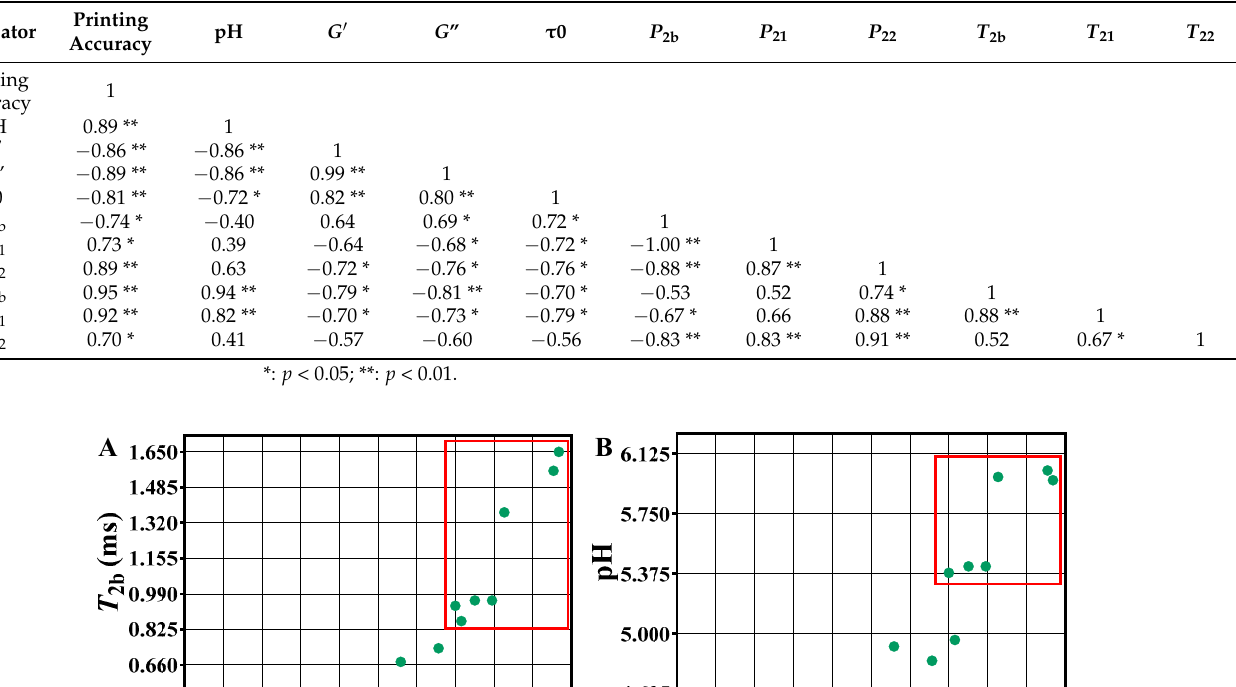
Table 5. Correlation between variables.